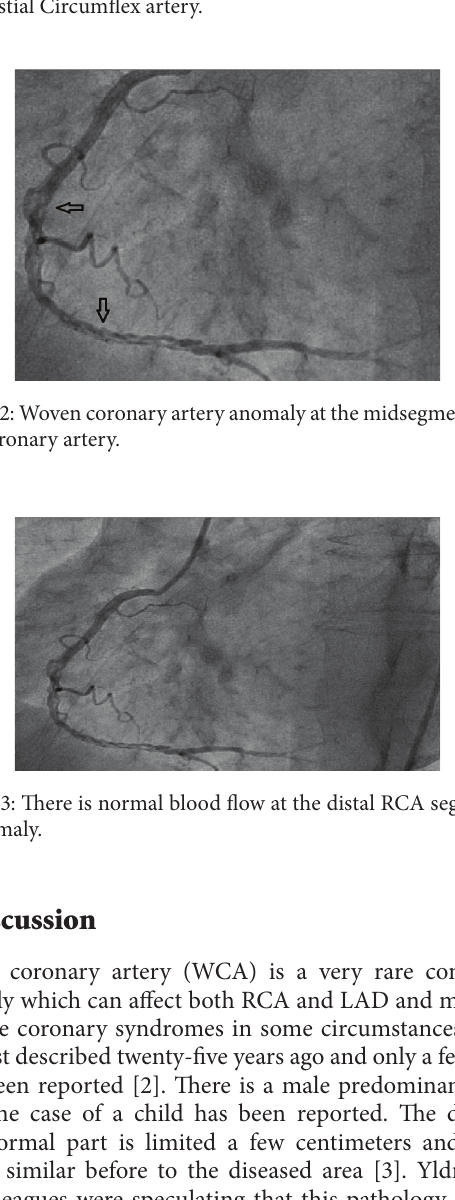
Figure 1: Plaques at left anterior descending artery and borderline lesion ostial Circumflex artery.